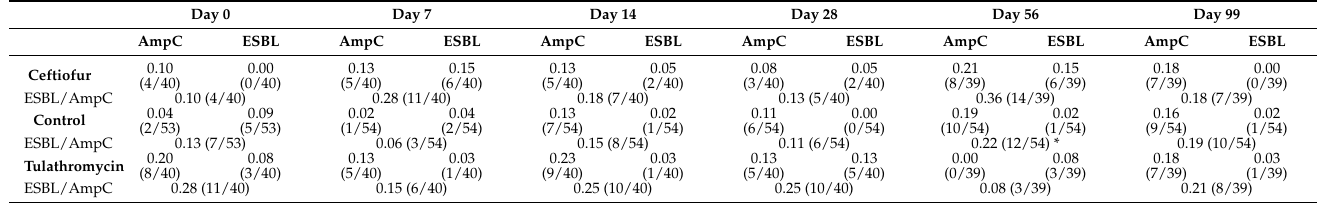
Table 1. Proportion of AmpC, ESBL, and ESBL/AmpC phenotypes across treatments and